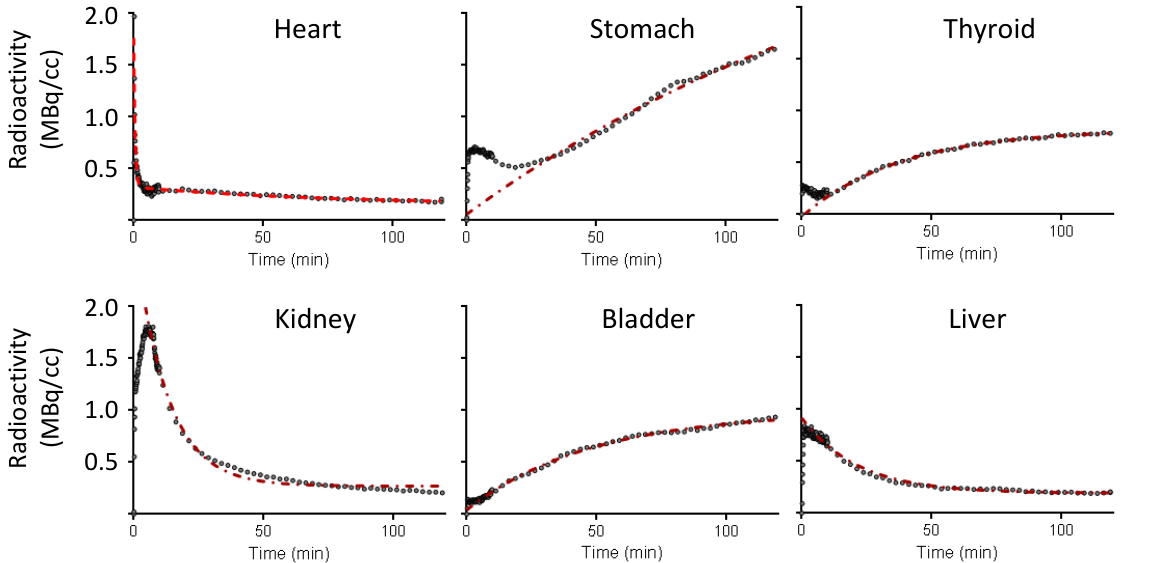
Figure 6. Pharmacokinetics of 124 I-p5+14 in WT mice over 2 h post-injection. Regions of interest were drawn on the PET data over the heart (blood pool), stomach, thyroid, kidney, bladder and liver. Time activity curves (TAC) were generated using Inveon Research Workplace software analysis package (filled circles). Exponential equations were used to quantify the rates of accumulation or loss of radioactivity in each tissue (red dashed line, Table 2). Goodness of fit (R 2 ) was >0.9 for all